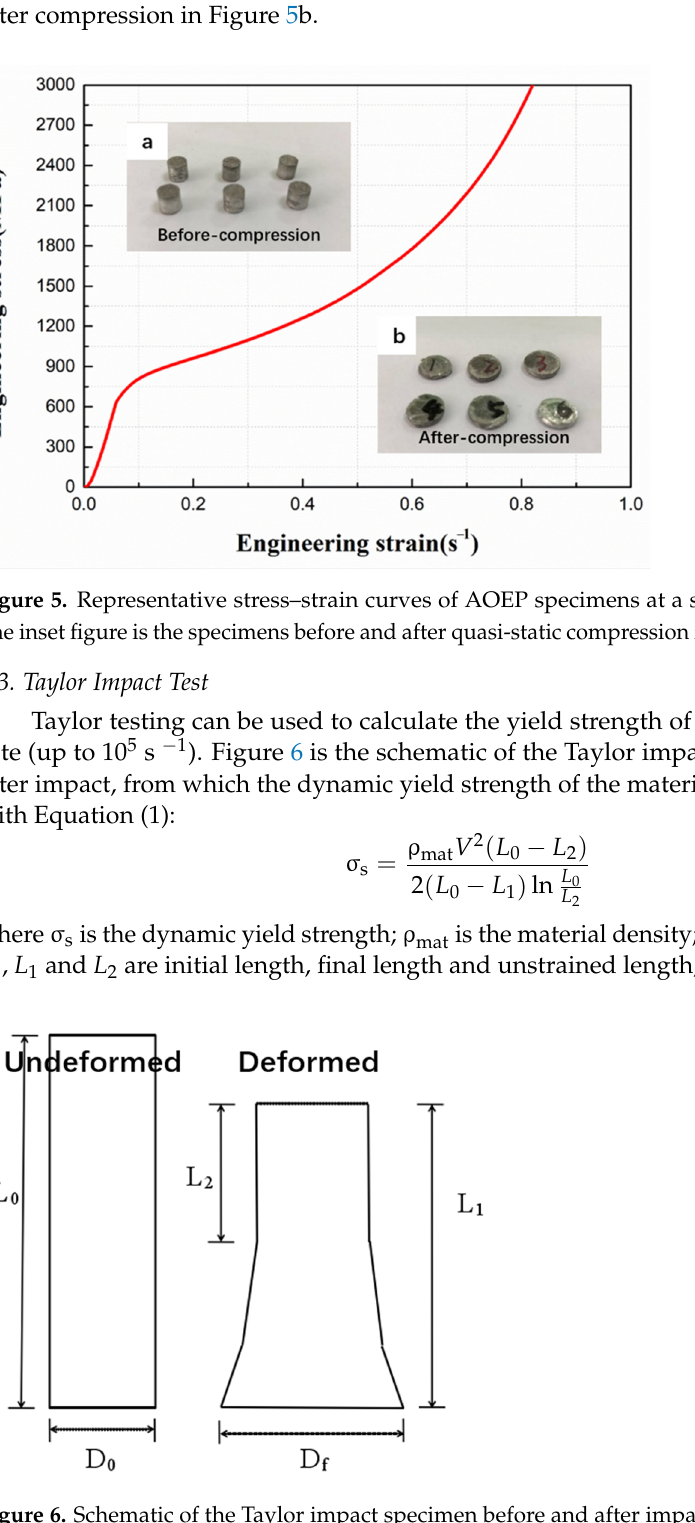
Figure 6. Schematic of the Taylor impact specimen before and after impact.